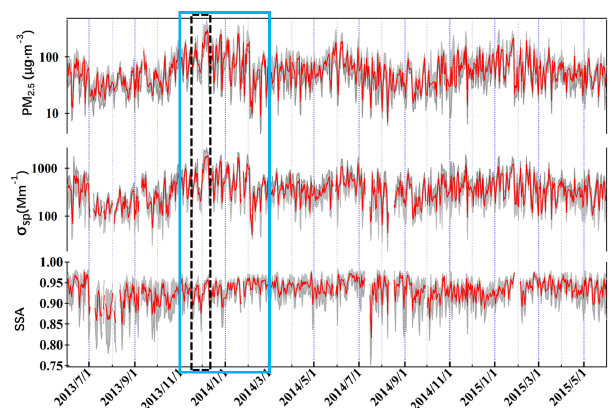
Figure 1. Daily averaged PM 2 . 5 concentrations, scattering coeffi- cients ( σ sp , λ = 525nm), absorption coefficients σ ap , λ = 520nm), and single-scattering albedo (SSA, λ = 520 nm) at SORPES in June 2013–May 2015. The grey shaded areas show the 10th to 90th percentile range of hourly-averaged data. The blue box shows the period discussed in Sect. 3.5 (and plotted in the Supplement, Fig. S11), the black box shows the period of Fig.